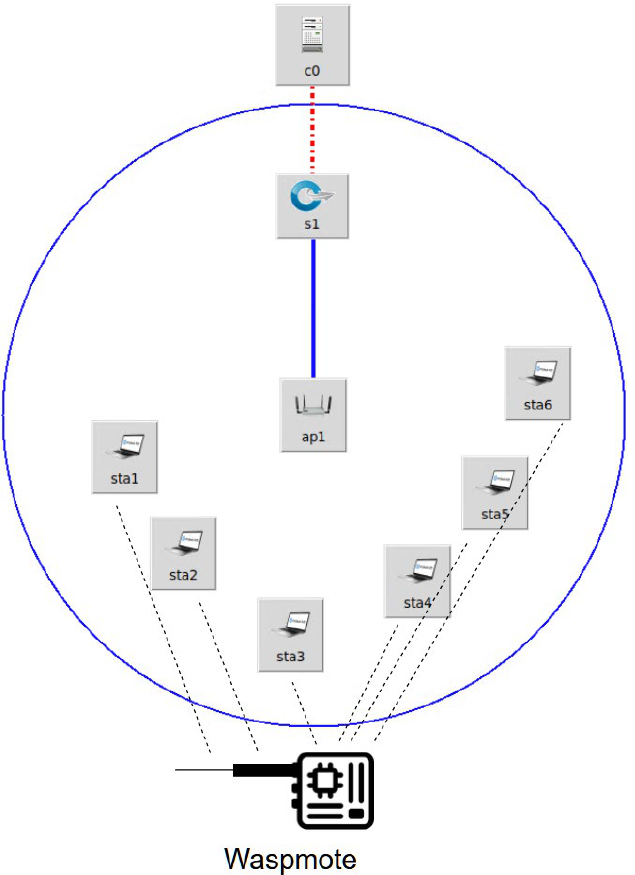
Figure 3. Design for scalability network topology using the Libelium Waspmote sensor.